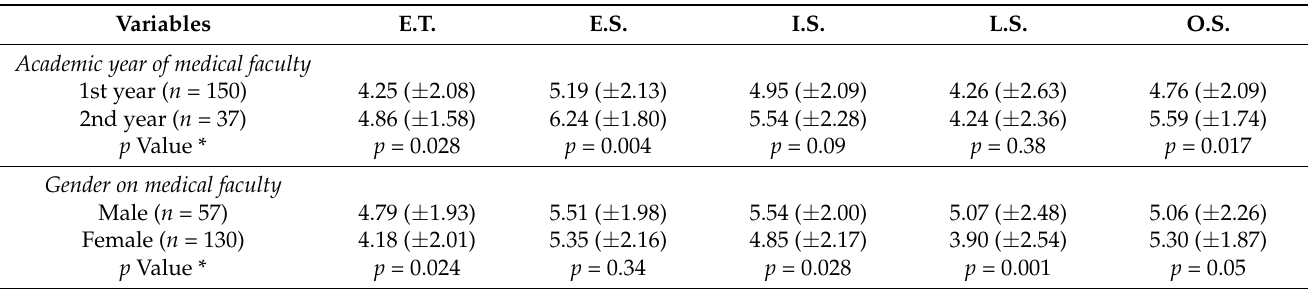
Table 6. Differences in scores obtained on the KPS scale and year of medical faculty and gender of medical